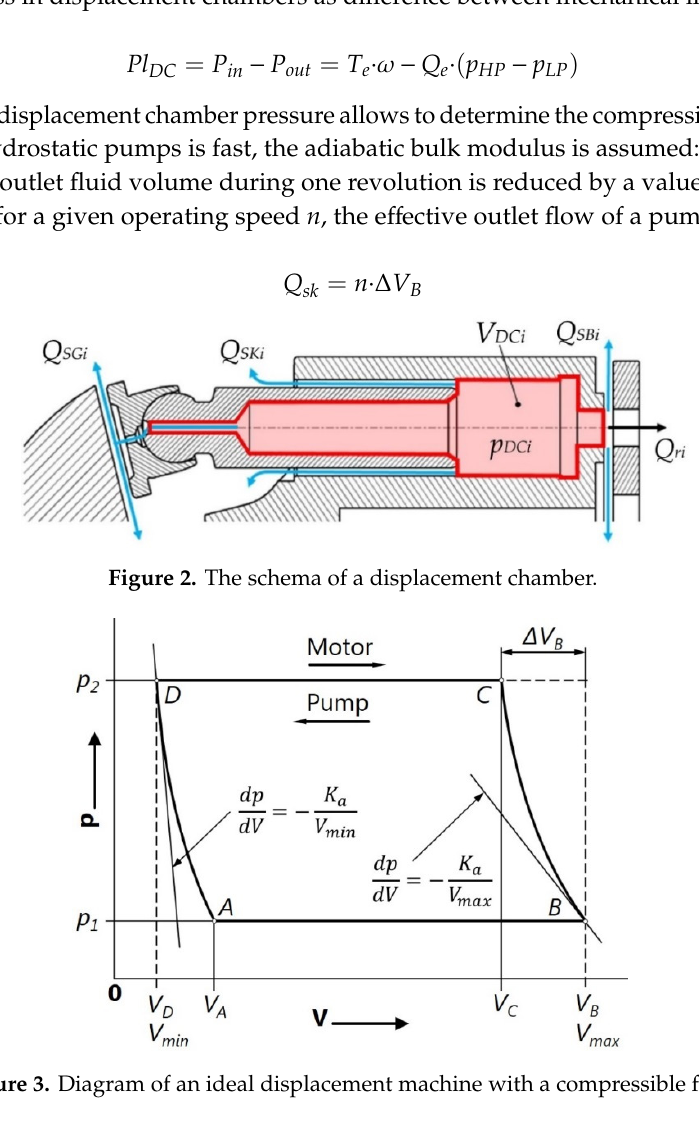
Figure 3. Diagram of an ideal displacement machine with a compressible fluid.